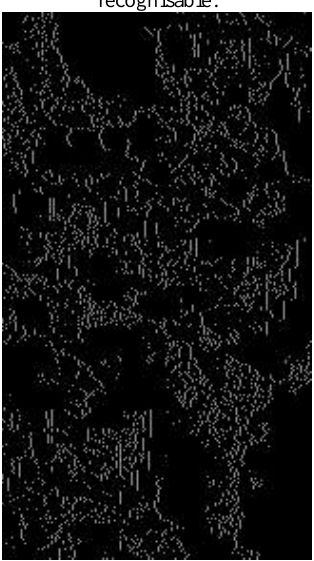
Figure 3. This figure depicts another outline from image segmentation on the original image after converting the original image to greyscale. This time a threshold was introduced to the process, but the output was